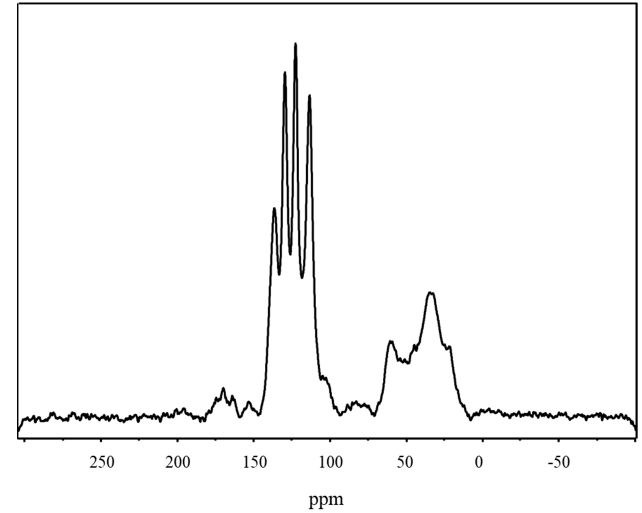
Figure A2. Solid-state 13 C CP/MAS-NMR spectrum of HPCP.